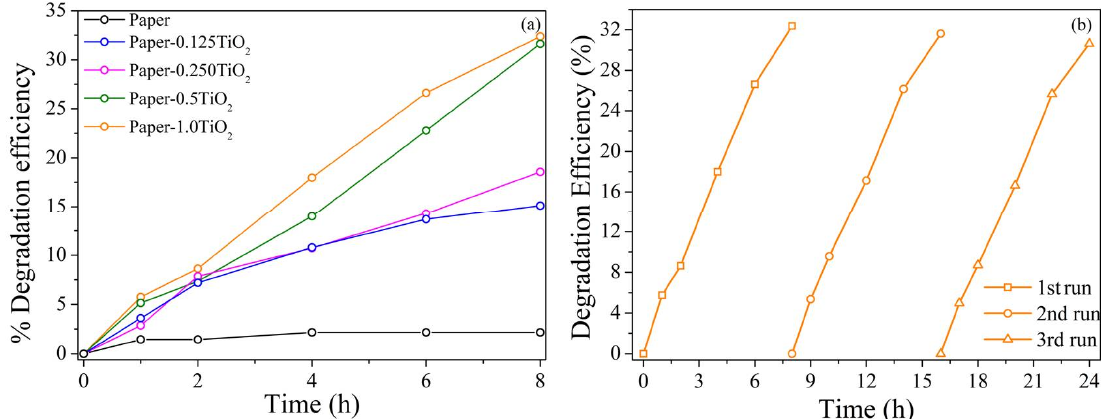
Figure 11. ( a ) Time evolution of modified paper with different loading of TiO 2 hydrosol on photocatalytic decomposition efficiency of methylene blue under 365 nm UV light irradiation. ( b ) Time evolution of a 1.0% TiO 2 -modified paper sheet on the photocatalytic decomposition efficiency of methylene blue under 365 nm UV light irradiation after three consecutive cycles. Table 2. Rate constant K for the degradation of methylene blue in water with different TiO 2 -modified paper sheets and TiO 2 nanoparticles at 365 nm UV light irradiation.